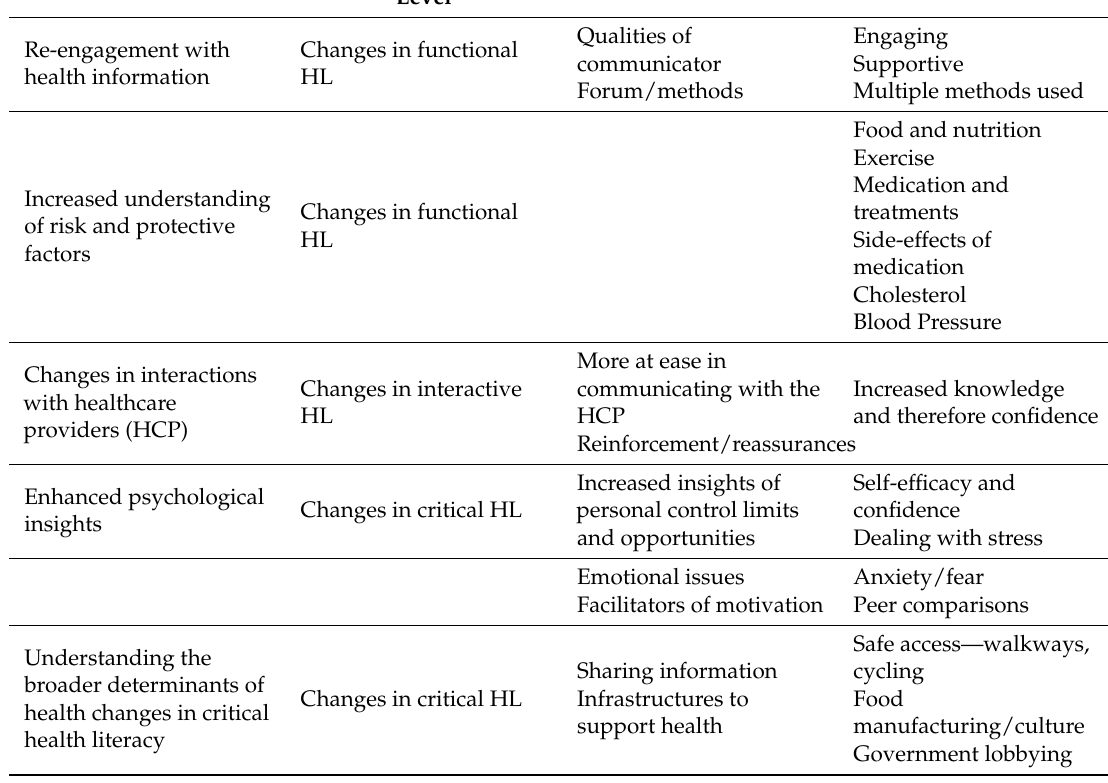
Table 4. Overview of themes and corresponding changes in levels of health literacy.